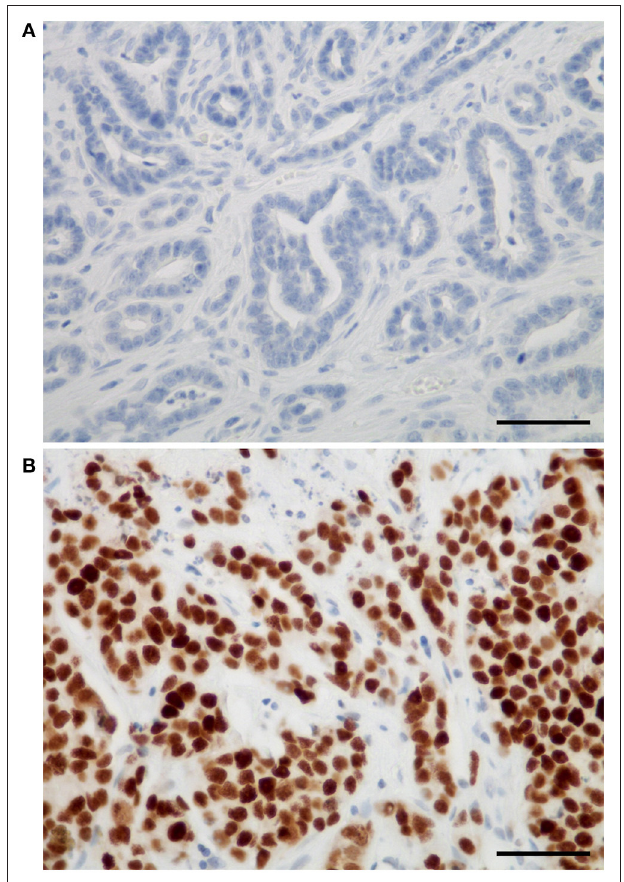
FIGURE 1 | Sox2 expression in feline mammary carcinomas. (A) Example of a feline tubular mammary carcinoma without any Sox2 expression. (B) Example of a feline solid mammary carcinoma with very high Sox2 expression. The positive immunohistochemical signal was strictly nuclear, and restricted to neoplastic cells (absent in stromal cells). Sox2 immunohistochemistry, original magnification 400 × , scale bars = 50 micrometers.